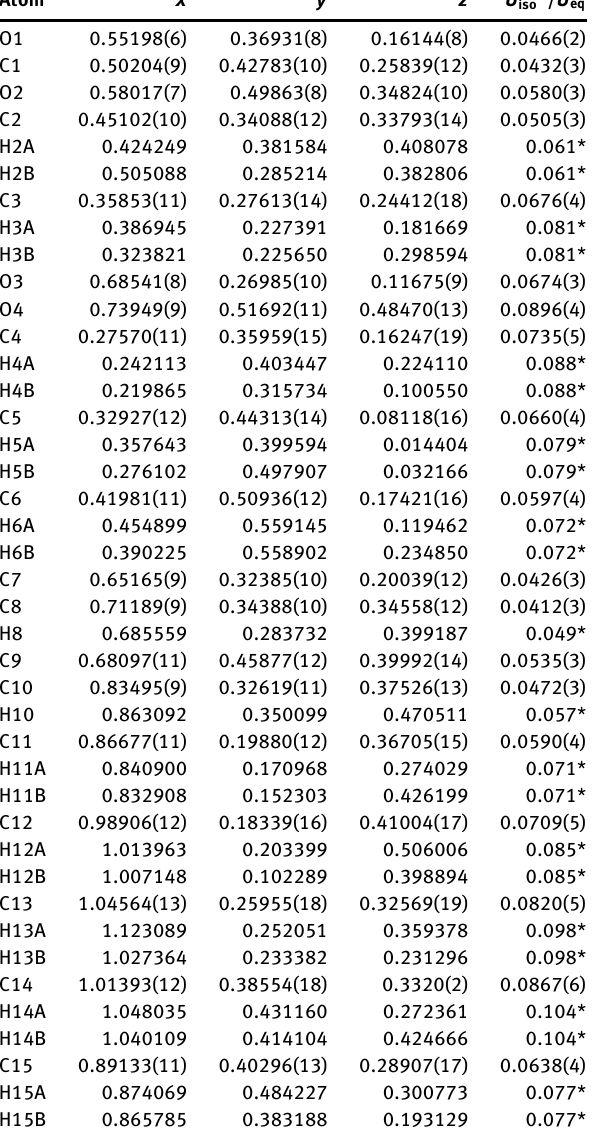
Table 2: Fractional atomic coordinates and isotropic or equivalent isotropic displacement parameters (Å 2